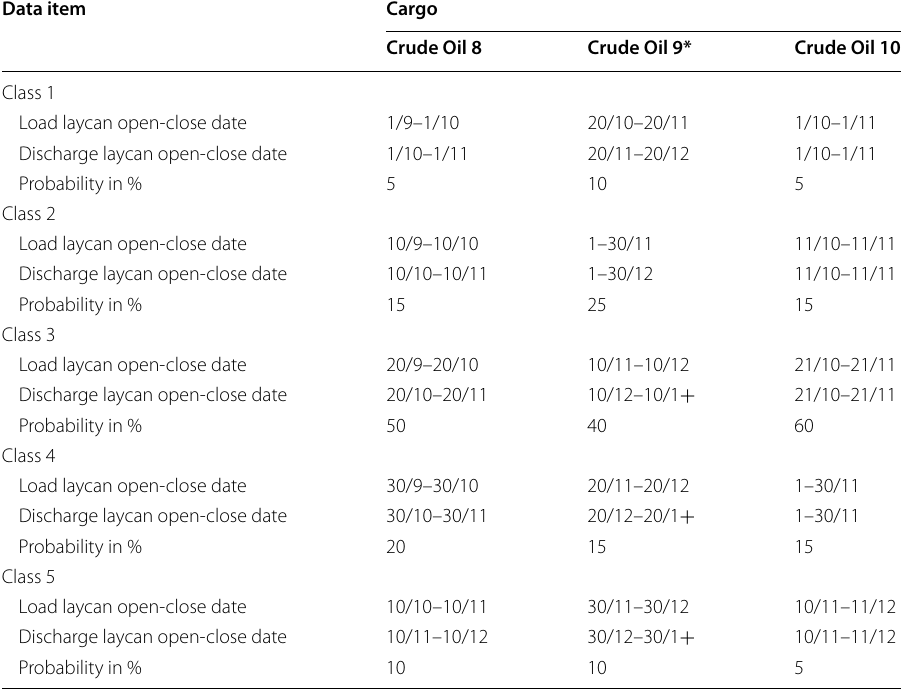
Table 5 Unconfirmed cargo additional laycan